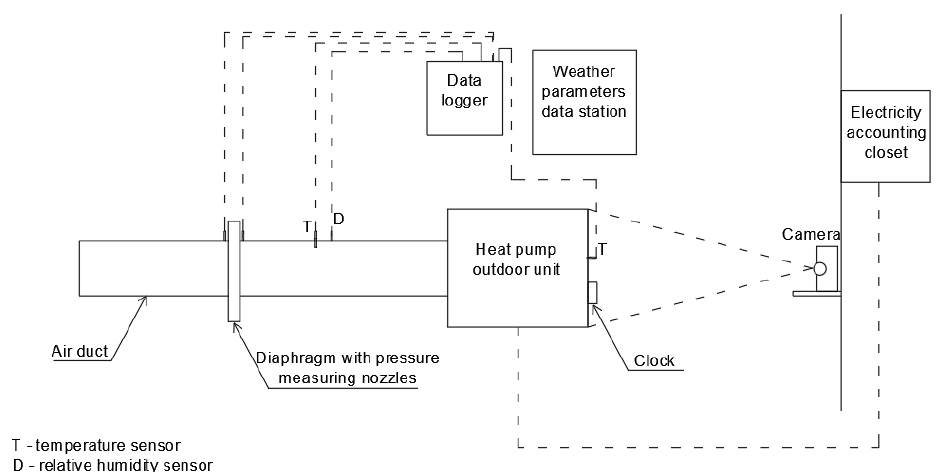
Figure 3. The principal scheme of the experimental setup.